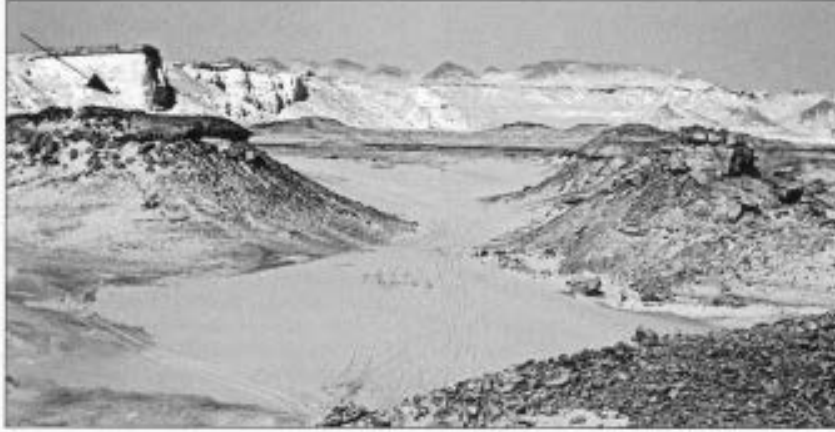
Figure 6 The El Obeiyid cavern (arrow) is located in an escarpment cliff face above Hidden Valley at Farafra; Wadi El Obeiyid in the foreground. Dated deposits of wind­ blown sand in the entrance to the cave demonstrate that intensification ofaeolian activity began about 7850 years ago.